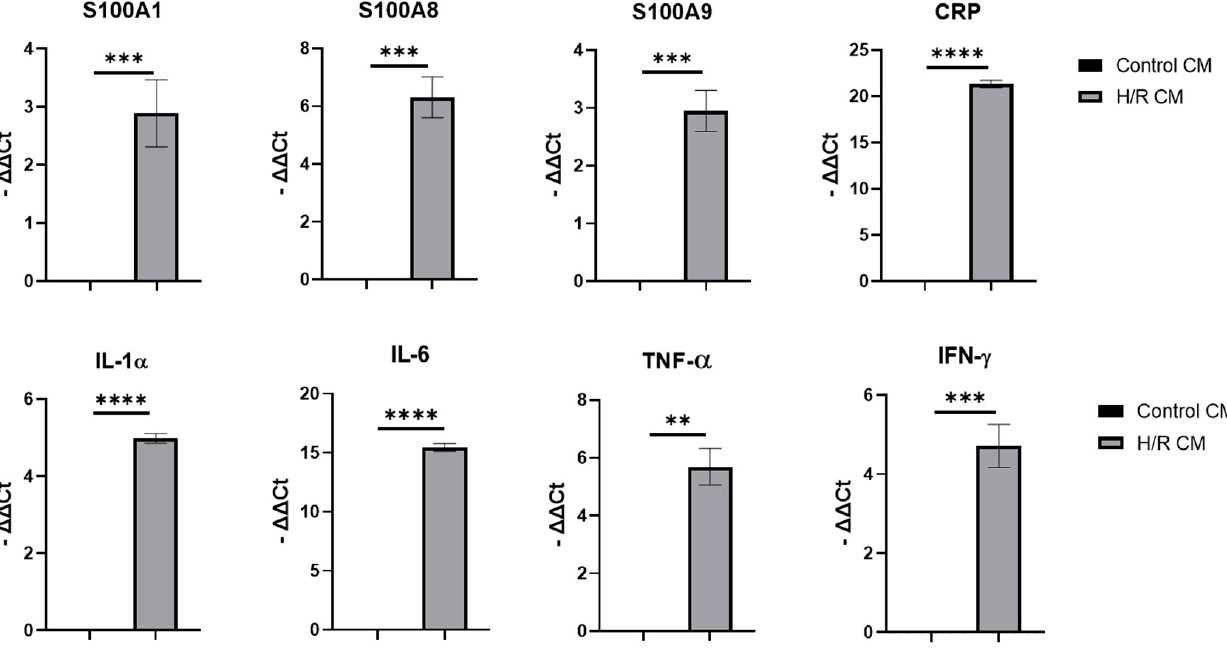
Figure 4. Analysis of the gene expressions in control cardiomyocyte group (Control CM) and H/R cardiomyocyte group (H/R CM) through qPCR. The significance among the groups was calculated using t test. ** p < 0.01, *** p < 0.001, **** p < 0.0001.